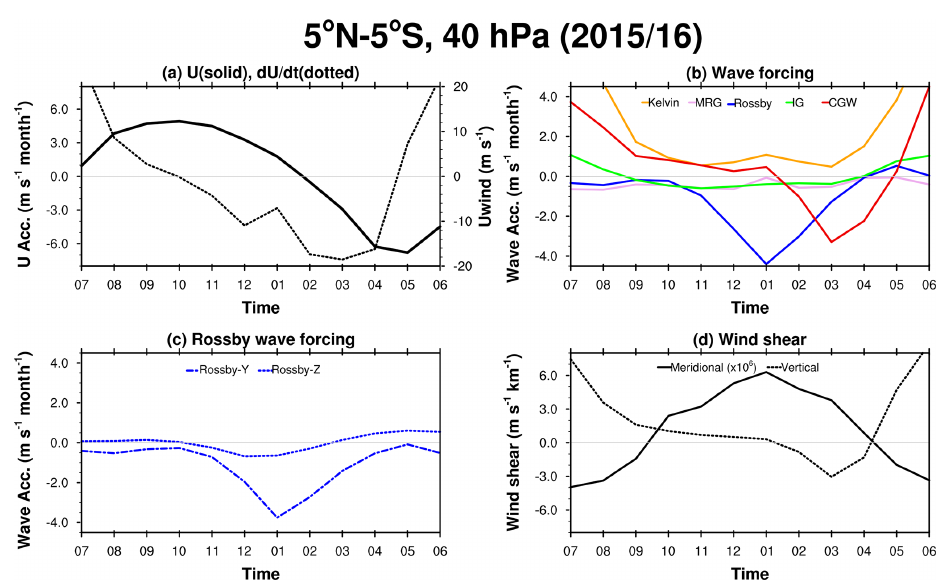
Figure 4. Time series of the (a) zonal-mean zonal wind (solid) and zonal wind tendency (dotted); (b) wave forcing by Kelvin waves (orange), MRG waves (pink), Rossby waves (blue), IG waves (light green), and CGWs (red); (c) meridional (dot-dashed) and vertical components (dotted) of the Rossby wave forcing; and (d) meridional wind shear across the Equator (solid) and vertical wind shear averaged over 5 ◦ N– 5 ◦ S (dotted) at 40hPa from July 2015 to June 2016. Table 1. Momentum forcing at 40hPa by each wave (ms − 1 per month) and its percentage contribution to the total negative wave forcing (parentheses) averaged over 5 ◦ N–5 ◦ S from October 2015 to March 2016 and for the climatology. The percentage is calculated when a wave forcing is negative during the QBO